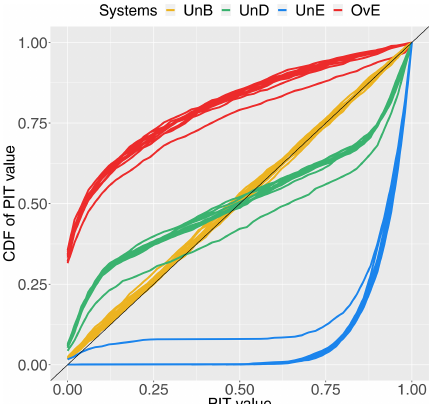
Figure 4. PIT diagram for 1d ahead synthetically generated fore- casts of different quality: unbiased system (UnB, yellow), underdis- persed system (UnD, green), underestimating system (UnE, blue) and overestimating system (OvE, red). For each system, each line represents one of the 10 studied catchments. Forecasts are based on ensembles generated with a 4% spread factor.